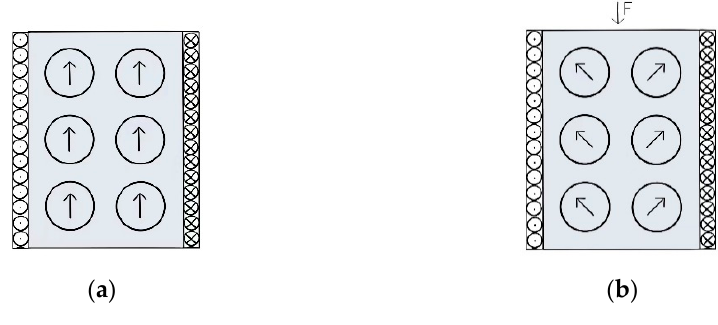
Figure 1. Magnetic domain distribution in iron-cobalt cylinder without force and under force.(a) Magnetic domain without force.(b) Magnetic domain under force.